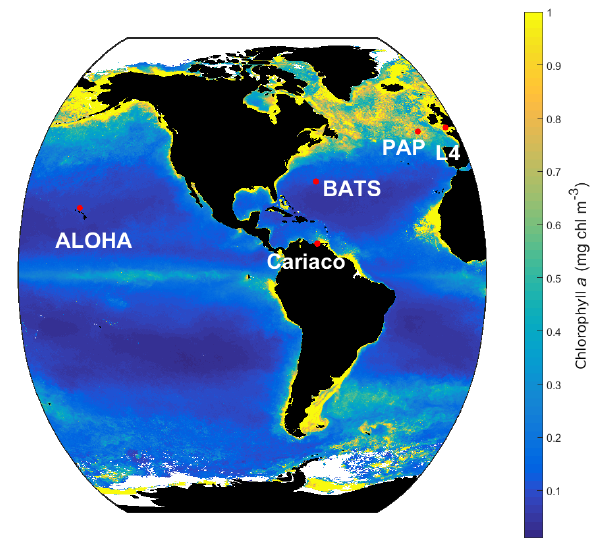
Figure 2. SeaWIFS-derived mean 1998 chlorophyll a (mgm − 3 ) overlain with the five oceanographic stations (red dots). These sta- tions are located in different oceanic regions: oligotrophic (ALOHA and BATS), coastal (L4 and Cariaco), and abyssal plain